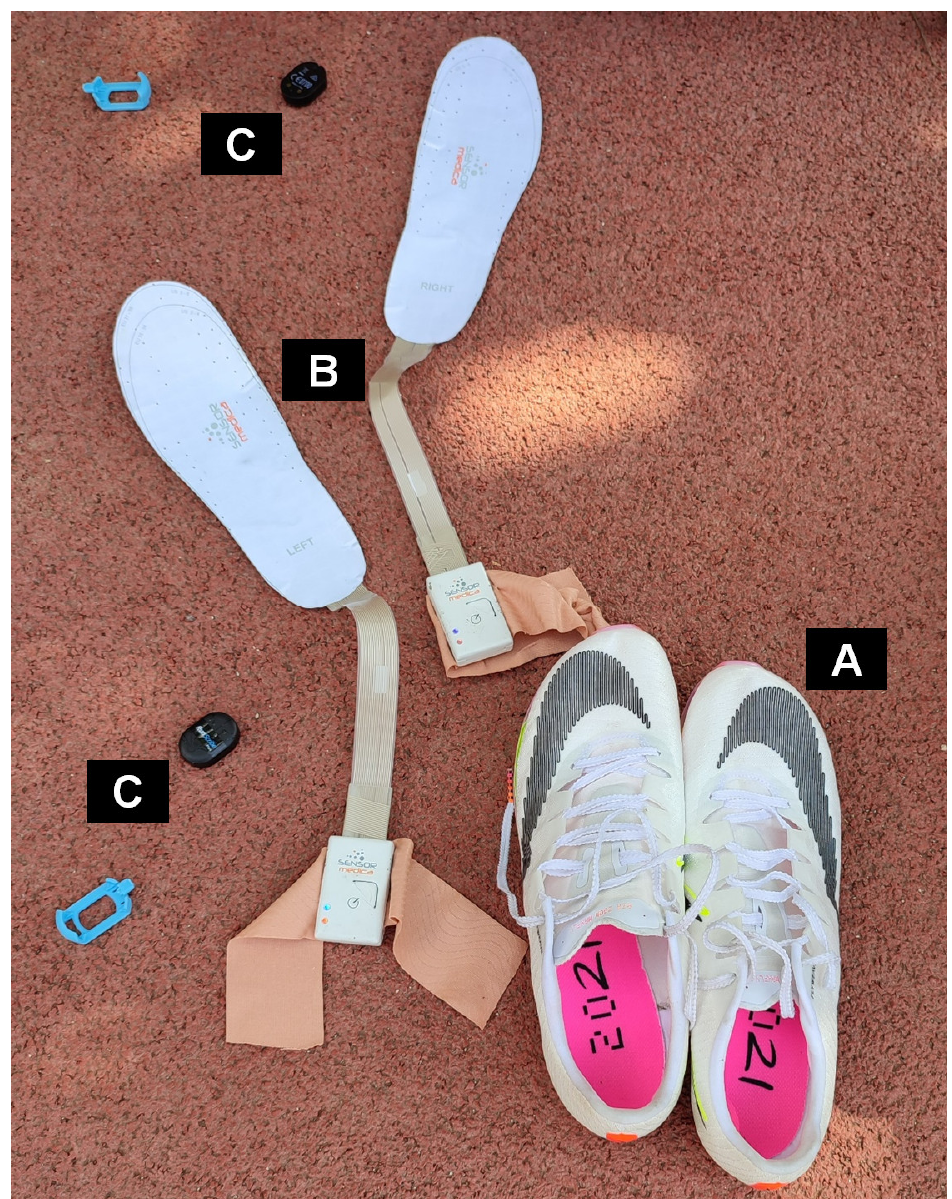
Figure 3. Instruments used during the running trials. ( A ) SSS Nike Air Zoom Victory 2021; ( B ) sensorized insoles, FlexInFit; ( C ) IMU applied on the laces of shoes, Runscribe.